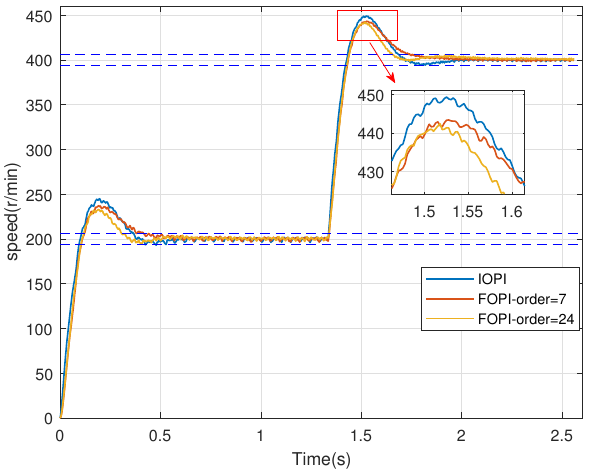
Figure 24. Speed variations response